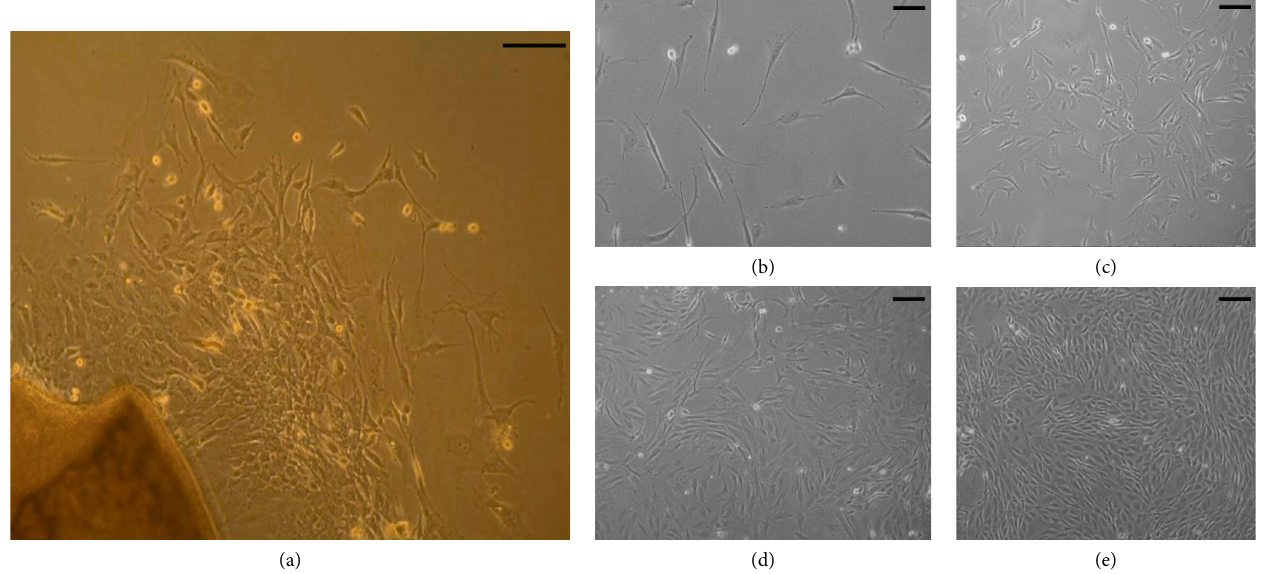
Figure 1: Magnification: 100x; Scale Bar: 100 μ m. (a) OM fragment plated by the explant method after enzymatic digestion. 1 week after plating, cells with morphological characteristics of MSCs irradiating from the explant can be observed; (b)–(e): morphology of OM-MSCs in culture: (b) P2, 30–40% confluence; (c) P5, 50–60% confluence; (d) P7, 70–80% confluence, ideal moment for passage; (e) P9, 90–100%